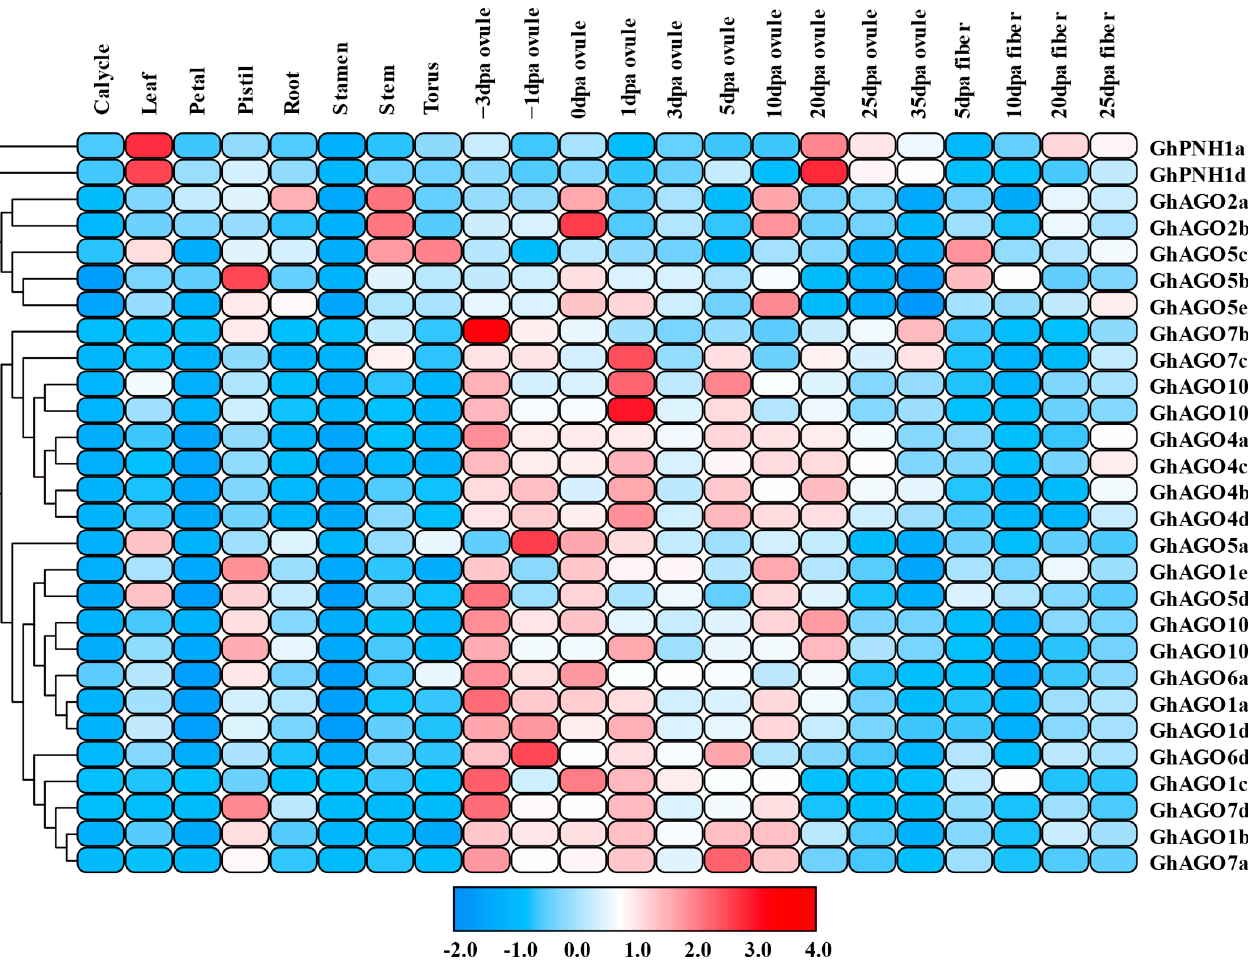
Figure 6. Expression profiles of the GhAGO genes in various tissues. The expression levels are illus- trated in different colors on the scale. Red represents high expression, and blue indicates low expression. dpa is an abbreviation for days post-anthesis.